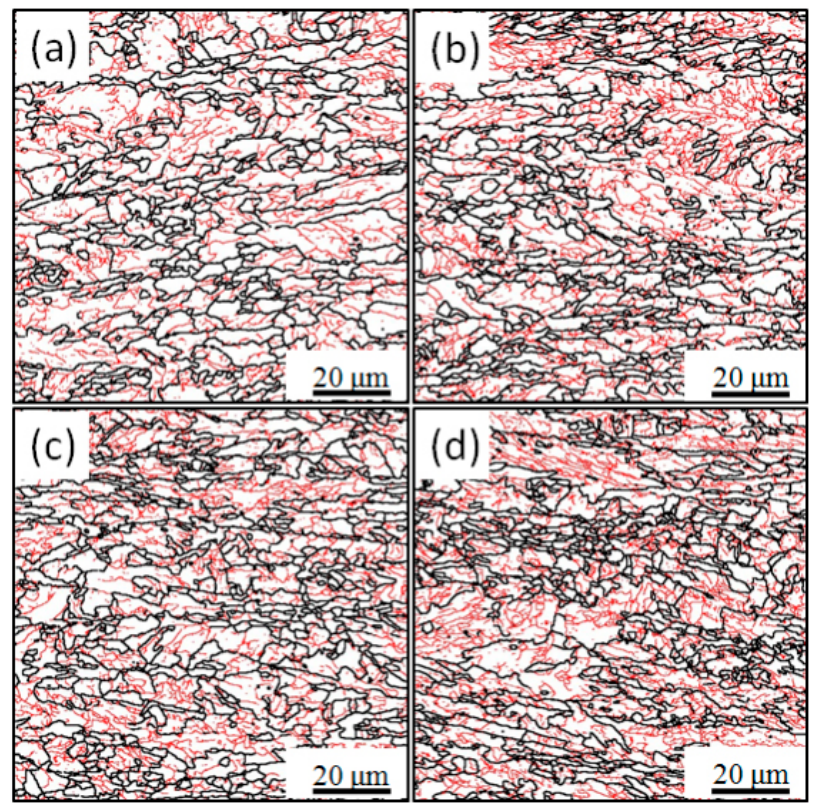
Figure 4. The grain boundaries misorientation angle distribution of the rolled samples for ( a ) Nb and ( b ) Nb-Mo steel, and the specimens of tensile test at 600 °C for ( c ) Nb and ( d ) Nb-Mo steels. Black and red lines indicate the ferrite grain boundary ( θ ≥ 15°) and low-angle boundary (2° ≤ θ ≤ 15°), respectively.